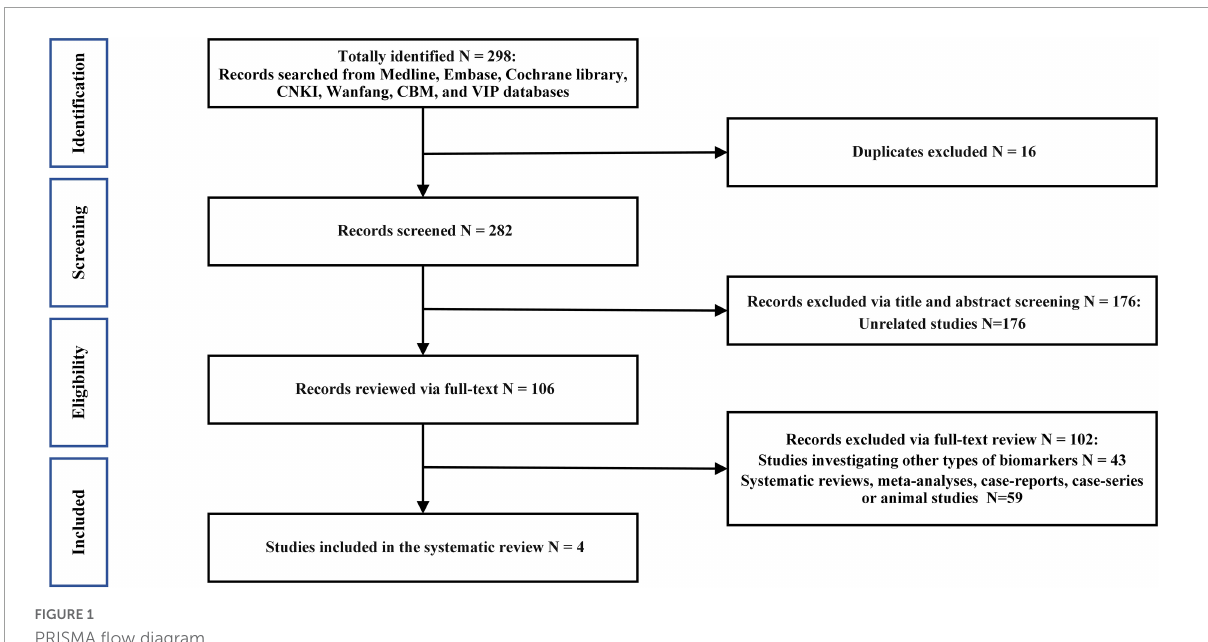
FIGURE1 PRISMA flow